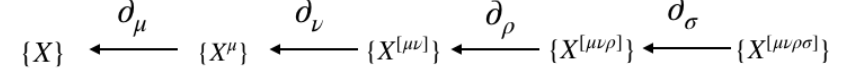
Figure 1. This is the diagram in the non-supersymmetric case. It terminates at order O ( D 4 ) , as explained in the text. The related maps are given by ∂ µ